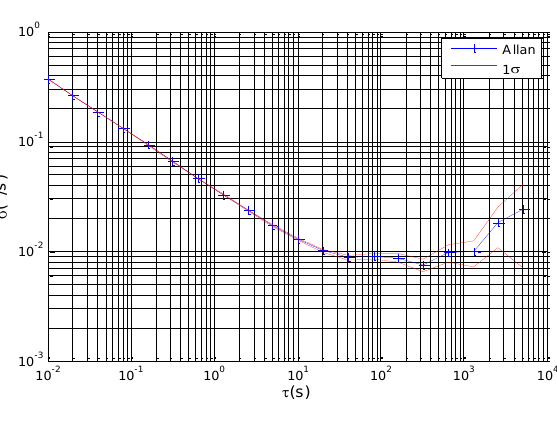
Figure 7. Raw data of Gyro Z.